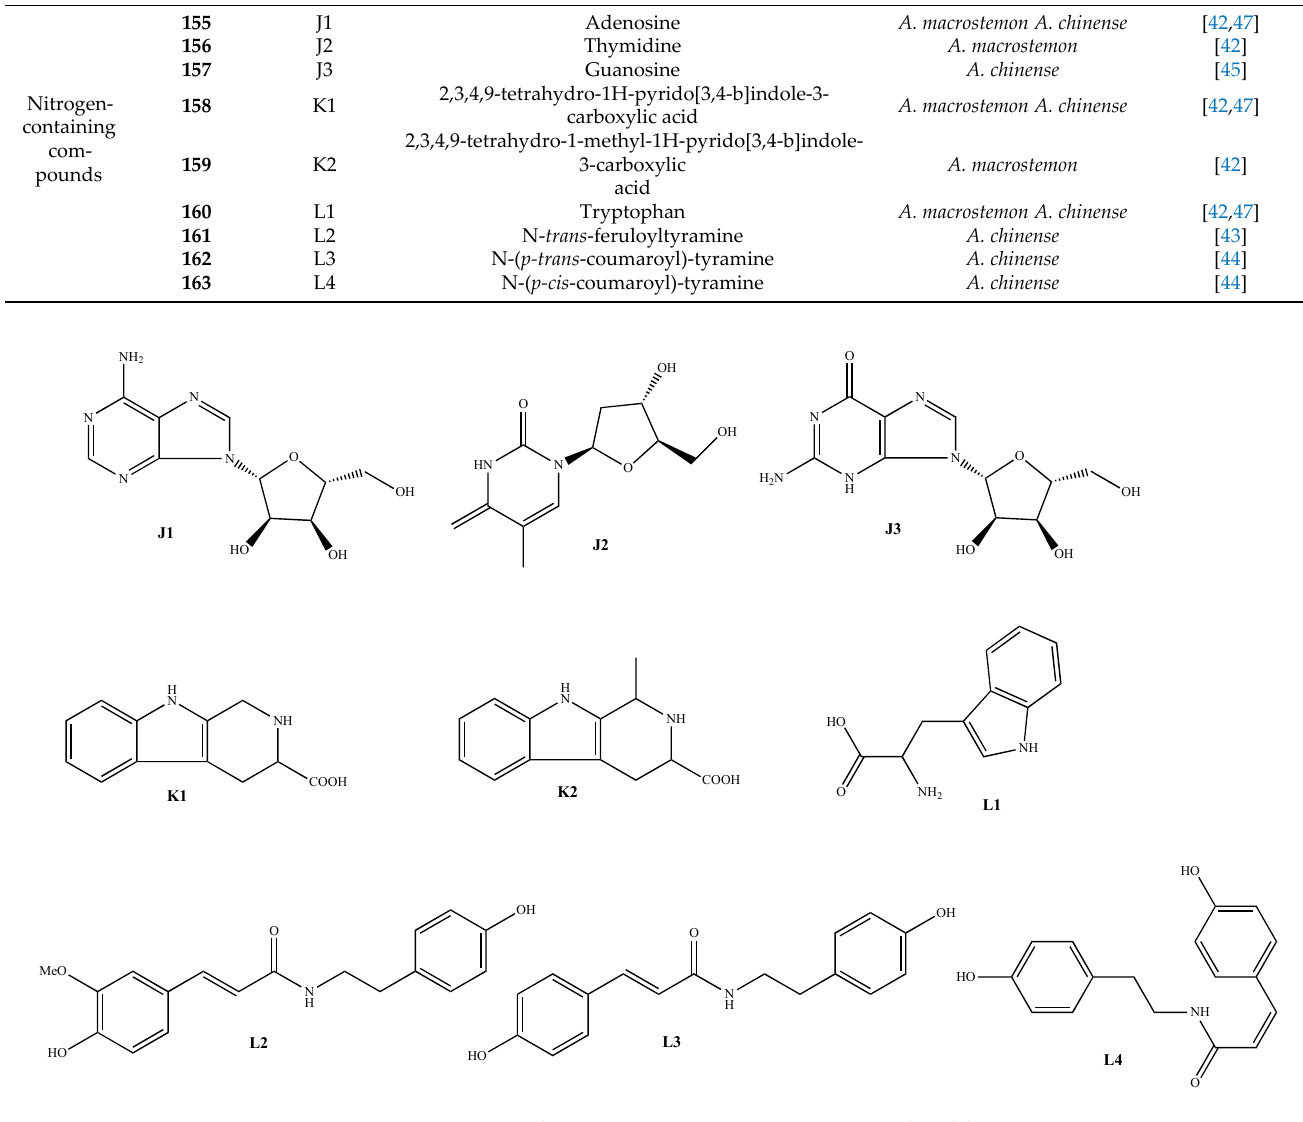
Figure 4. Structure of nitrogen-containing components isolated from AMB.